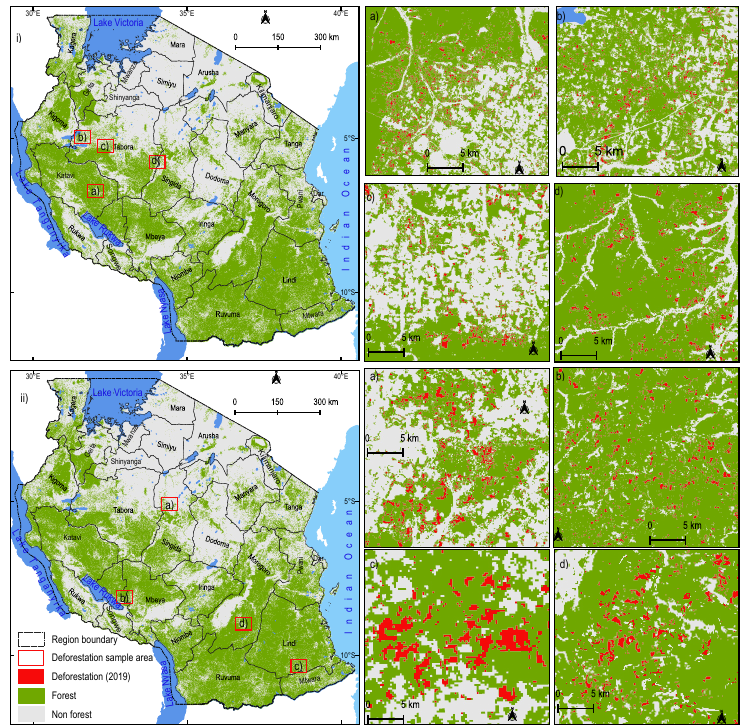
Figure 9. Map showing deforestation area for 2019 with detailed sample areas ( i ) ( a – d ) and ( ii ) ( a – d